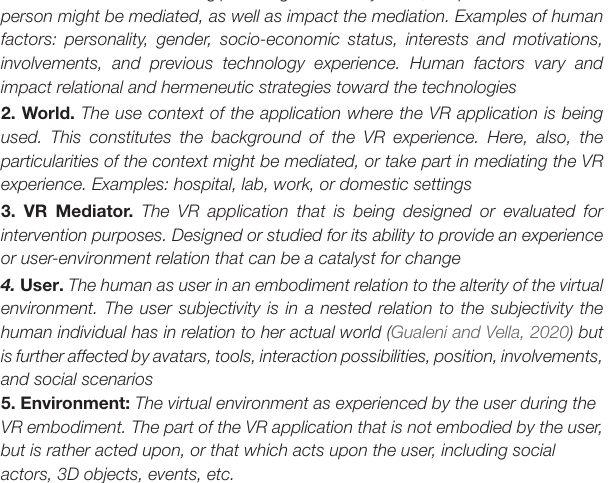
TABLE 2 | Overview of Framework